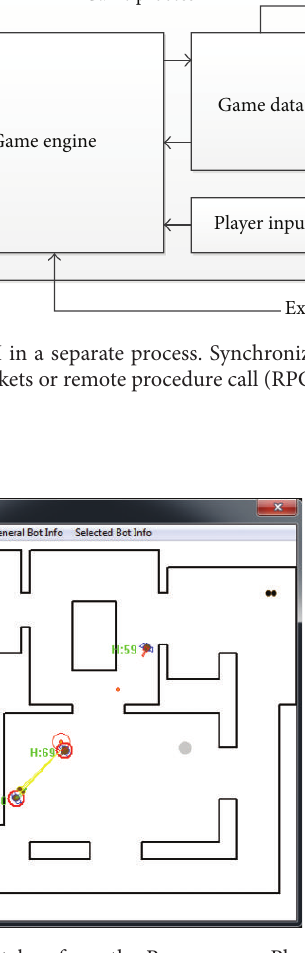
Figure 13: Screenshot taken from the Raven game. Player spawn locations are drawn in gray. On the top right corner is a Shotgun in black. At the bottom is a Rocket Launcher. At the left are a Railgun and a health pack. Each bot has its current hit points drawn next to it.